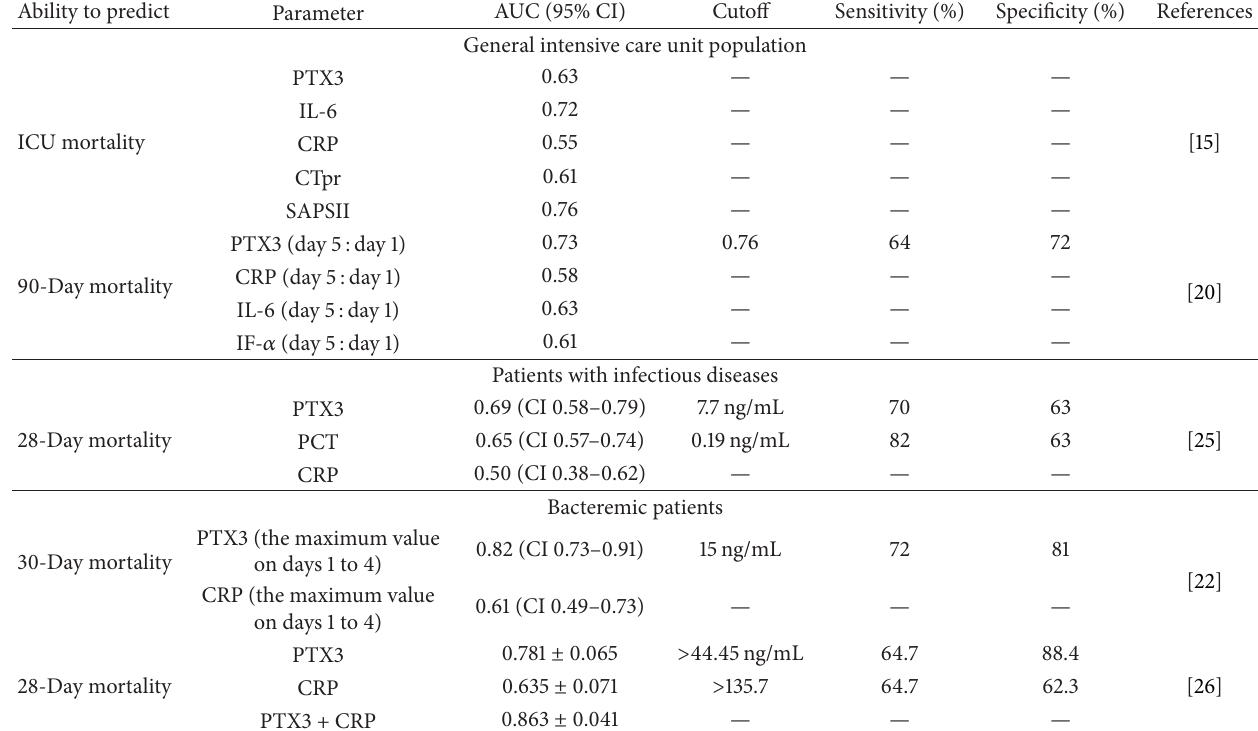
Table 3: Prognostic value of PTX3 to predict mortality as compared to other biological markers and disease severity scores. Ability to